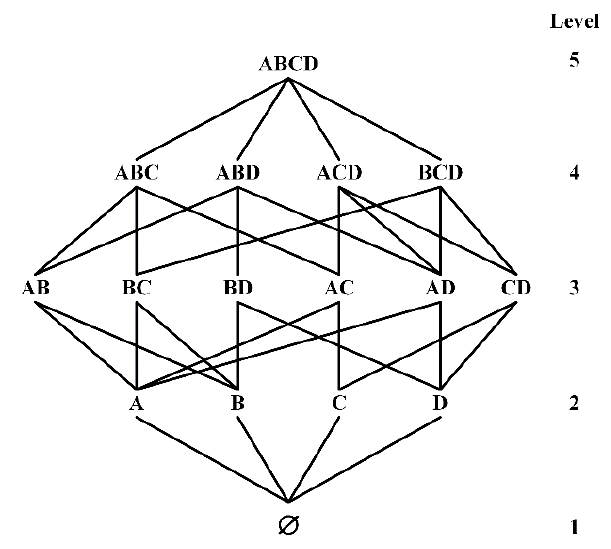
Figure 3. Candidate FDs composed of attribute sets A, B, C, D.